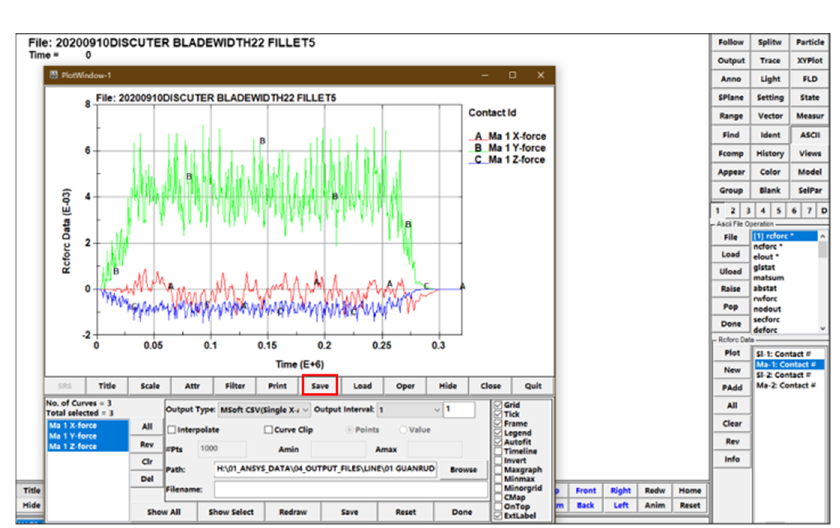
Figure 14. Plot the contact force.